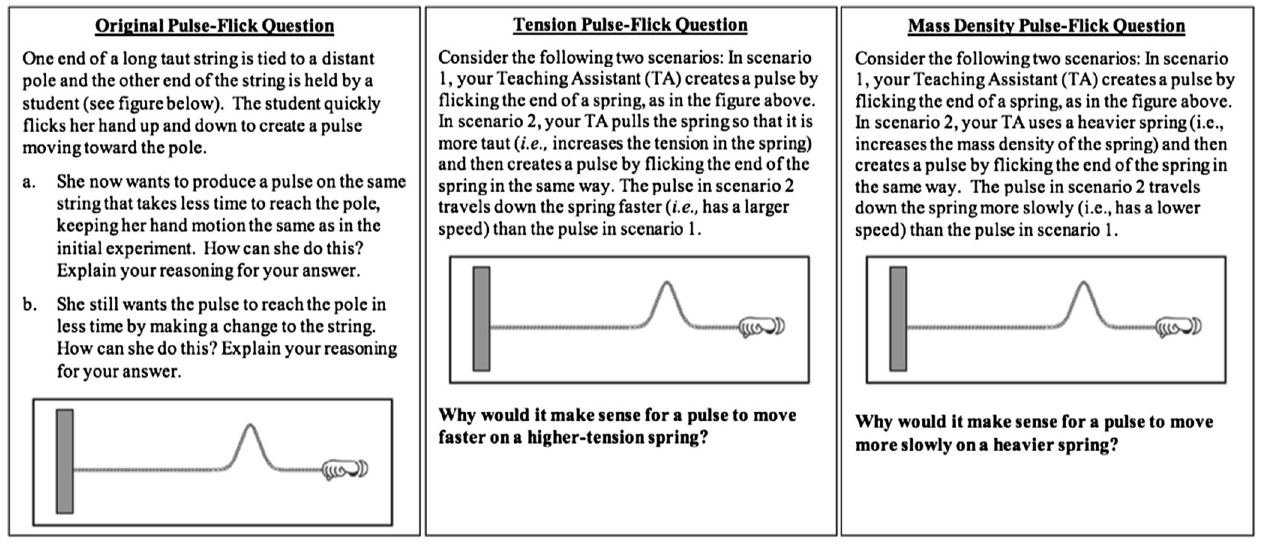
FIG. 2. Three versions of the pulse-flick question. The original question is drawn from Tongchai et al. and is modified from Wittmann ’ s Waves Diagnostic